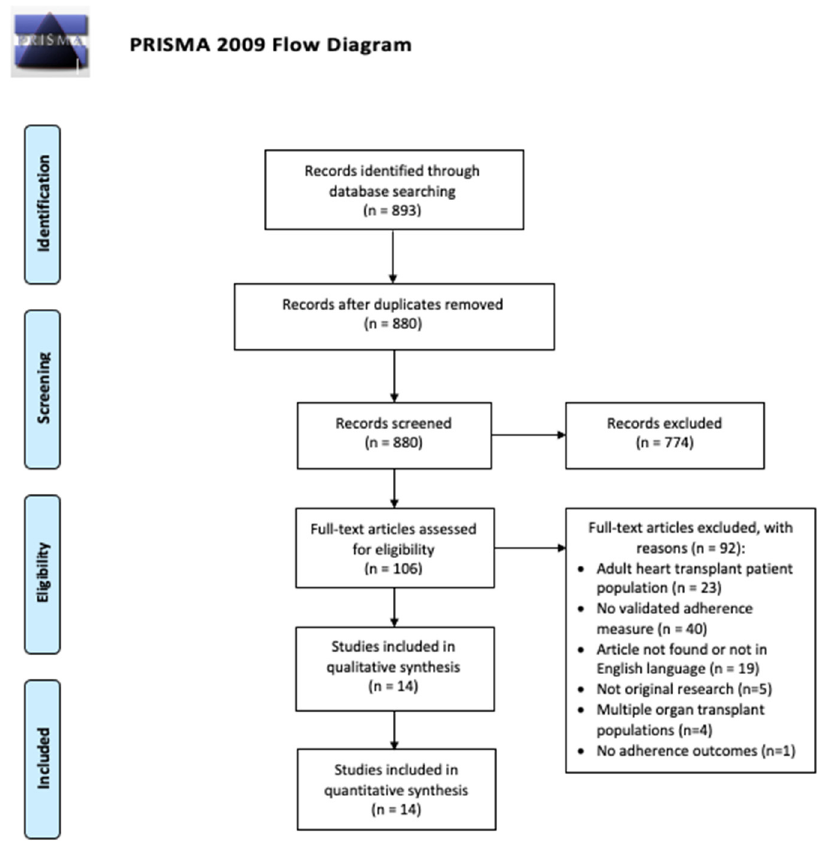
Figure 1. PRISMA Flow Diagram for the included studies.